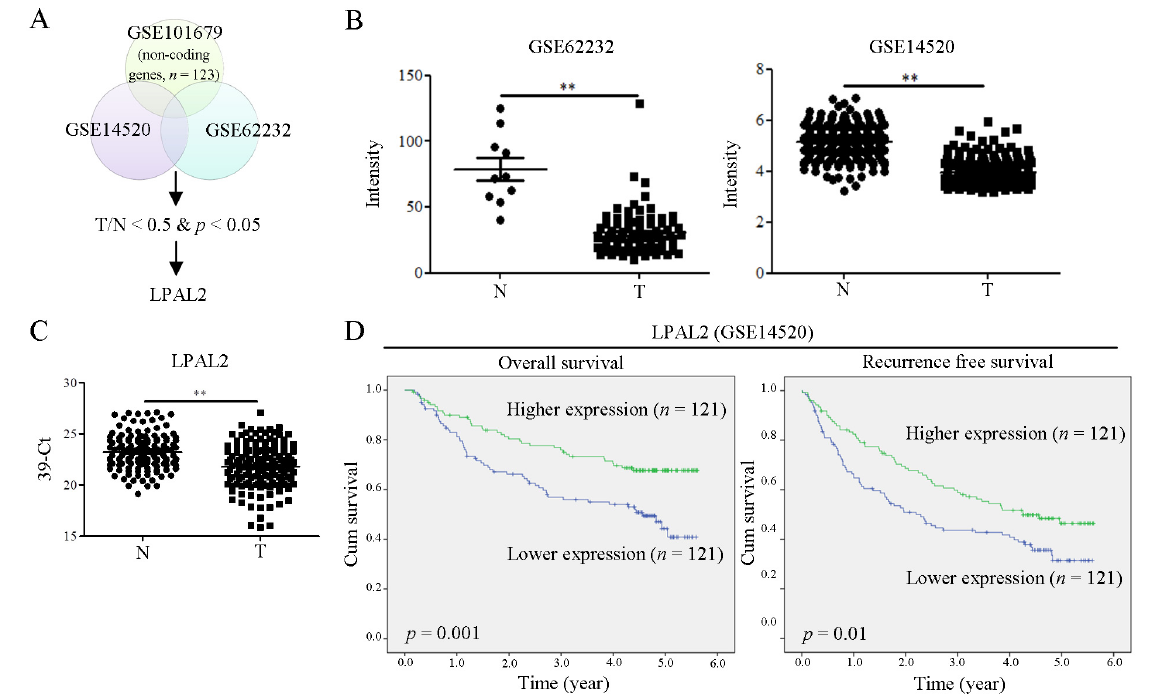
Figure 1. LPAP2 expression is downregulated in HCC tissues and is positively correlated with survival outcomes. ( A ) Differential expression of lncRNAs in tumor (T) and normal (N) tissue in HCC specimens (T/N < 0.5) was analyzed by microarray profiling analysis, which was uploaded to NCBI’s GEO dataset (GES101679). Identified targets were subsequently correlated with HCC tumors using online-available GSE14520 and GSE62232 datasets, an analysis that showed that LPAL2 expression was low in HCC tumors. ( B ) Intensity of LPAL2 in GSE62232 and GSE14520 datasets is shown. **, p < 0.01. ( C ) LPAL2 expression levels in our cohort of HCC specimens ( n = 157), determined by qRT-PCR. 18s rRNA was used as a loading control. **, p < 0.01. ( D ) Effect of LPAL2 expression on survival outcomes was determined by Kaplan–Meier survival curve analysis using a log-rank